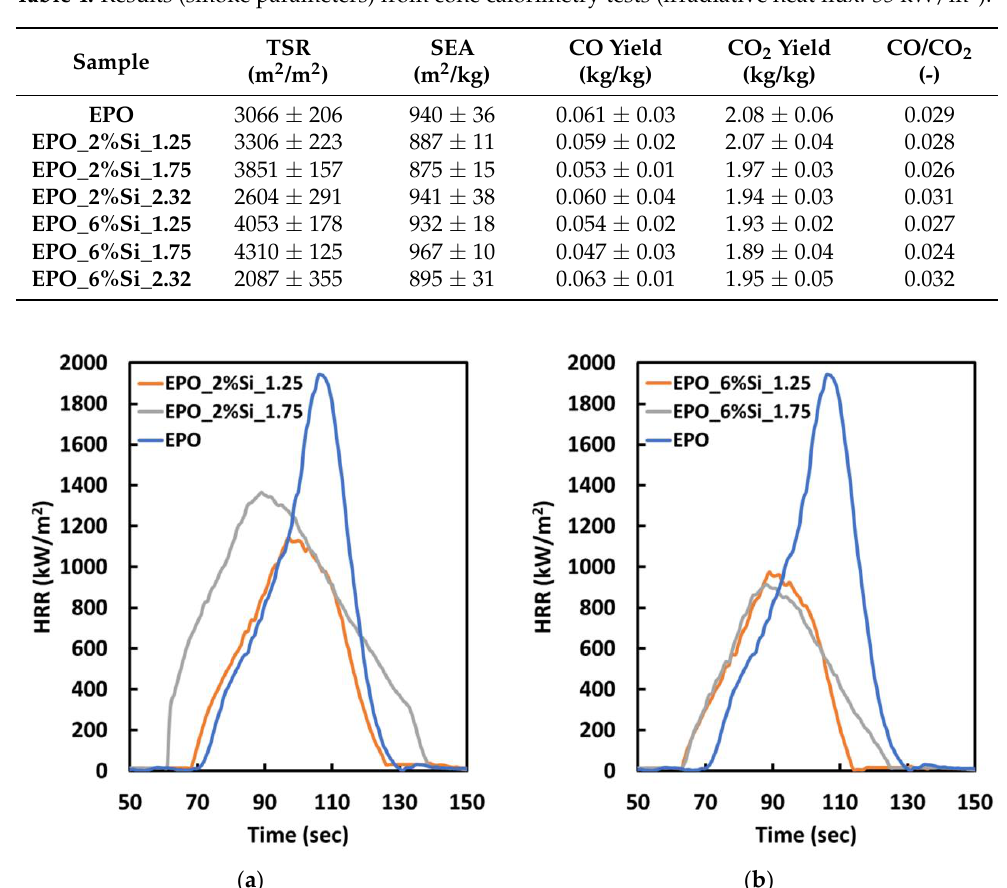
Table 4. Results (smoke parameters) from cone calorimetry tests (irradiative heat flux: 35 kW/m 2 ).